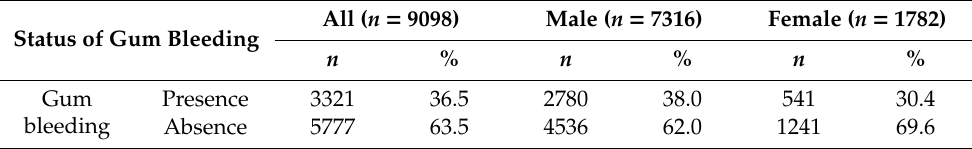
Table 1. Proportion of students with gum bleeding among the 9098 late adolescents. All ( n = Status of Gum Bleeding